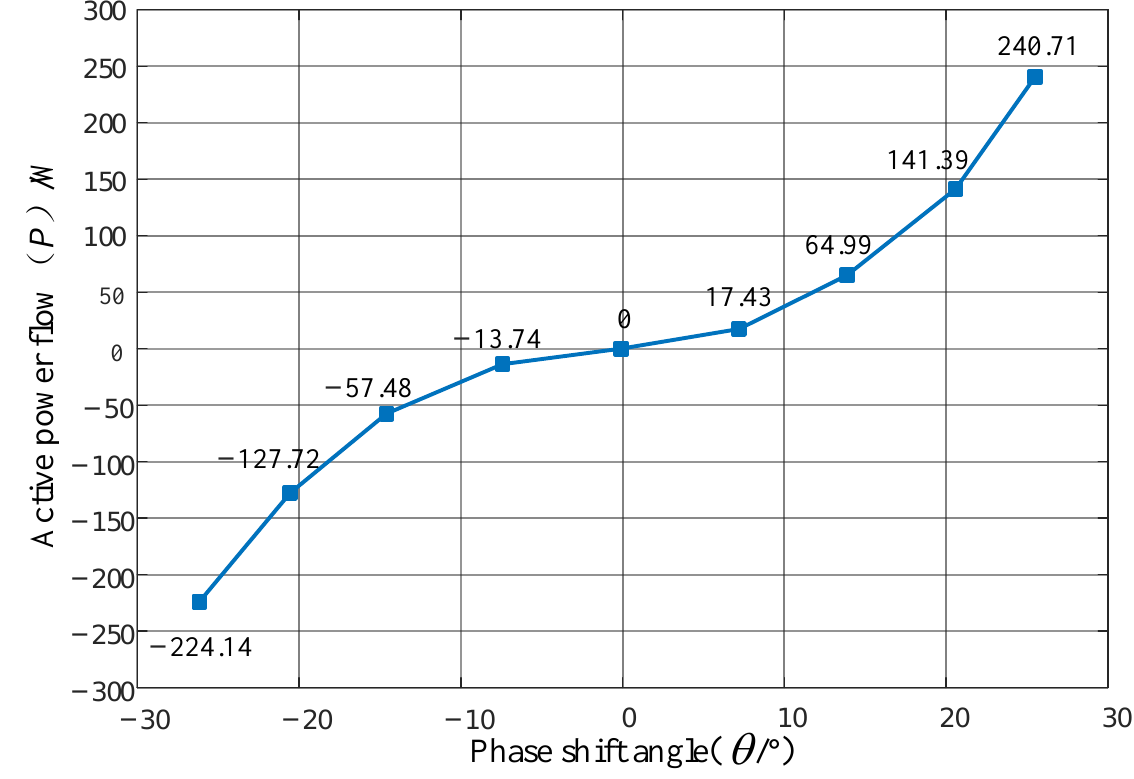
Figure 20. Relationship between line active power flow and phase shift angle .